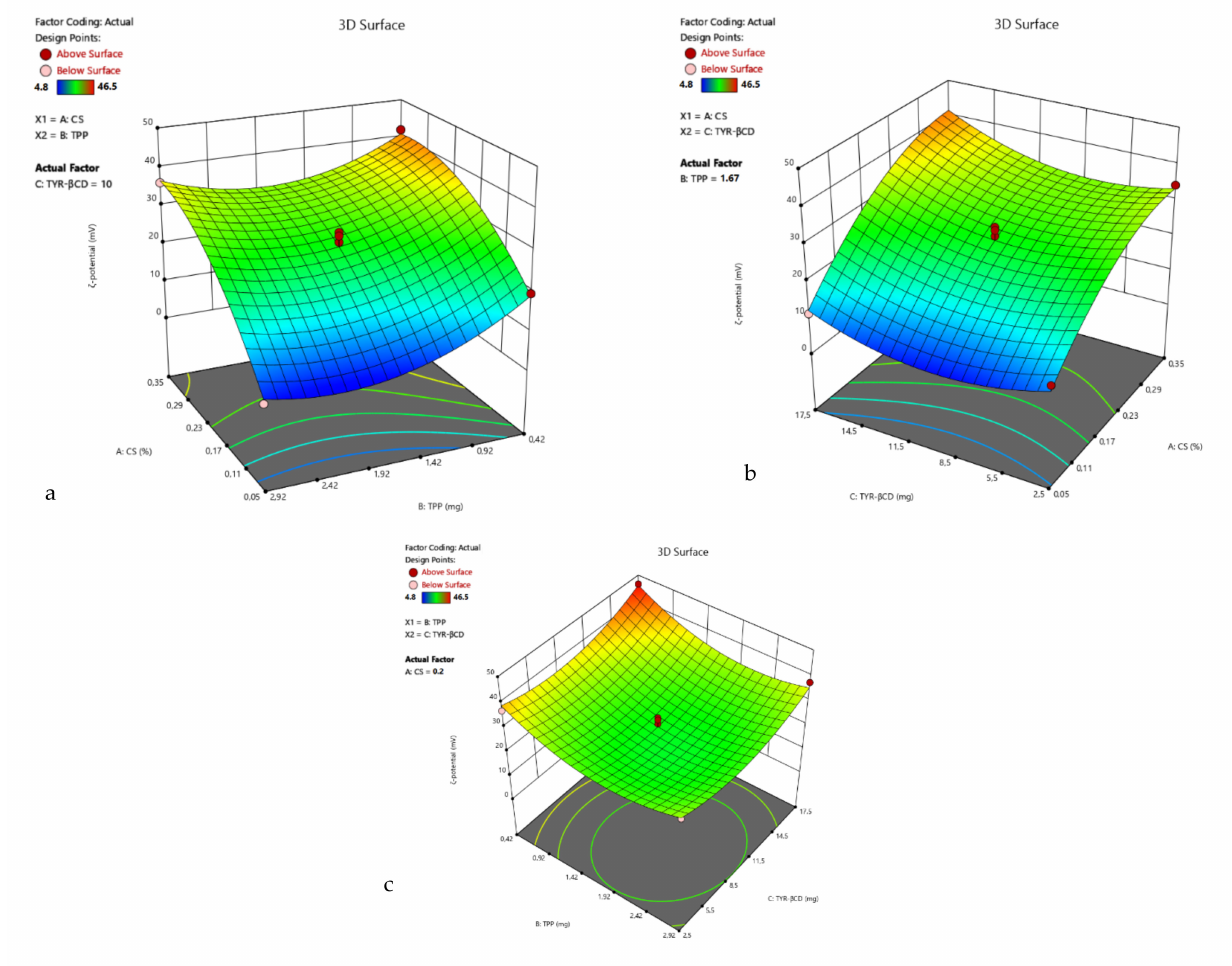
Figure 5. 3D surface plot of response R 2 of the TYR- β CD/CS system ( a ) CS Vs TPP (TYR- β CD: 10 mg) ( b ) CS Vs TYR- β CD (TPP: 1.67 mg) ( c ) TPP Vs TYR- β CD (CS: 0.2%).